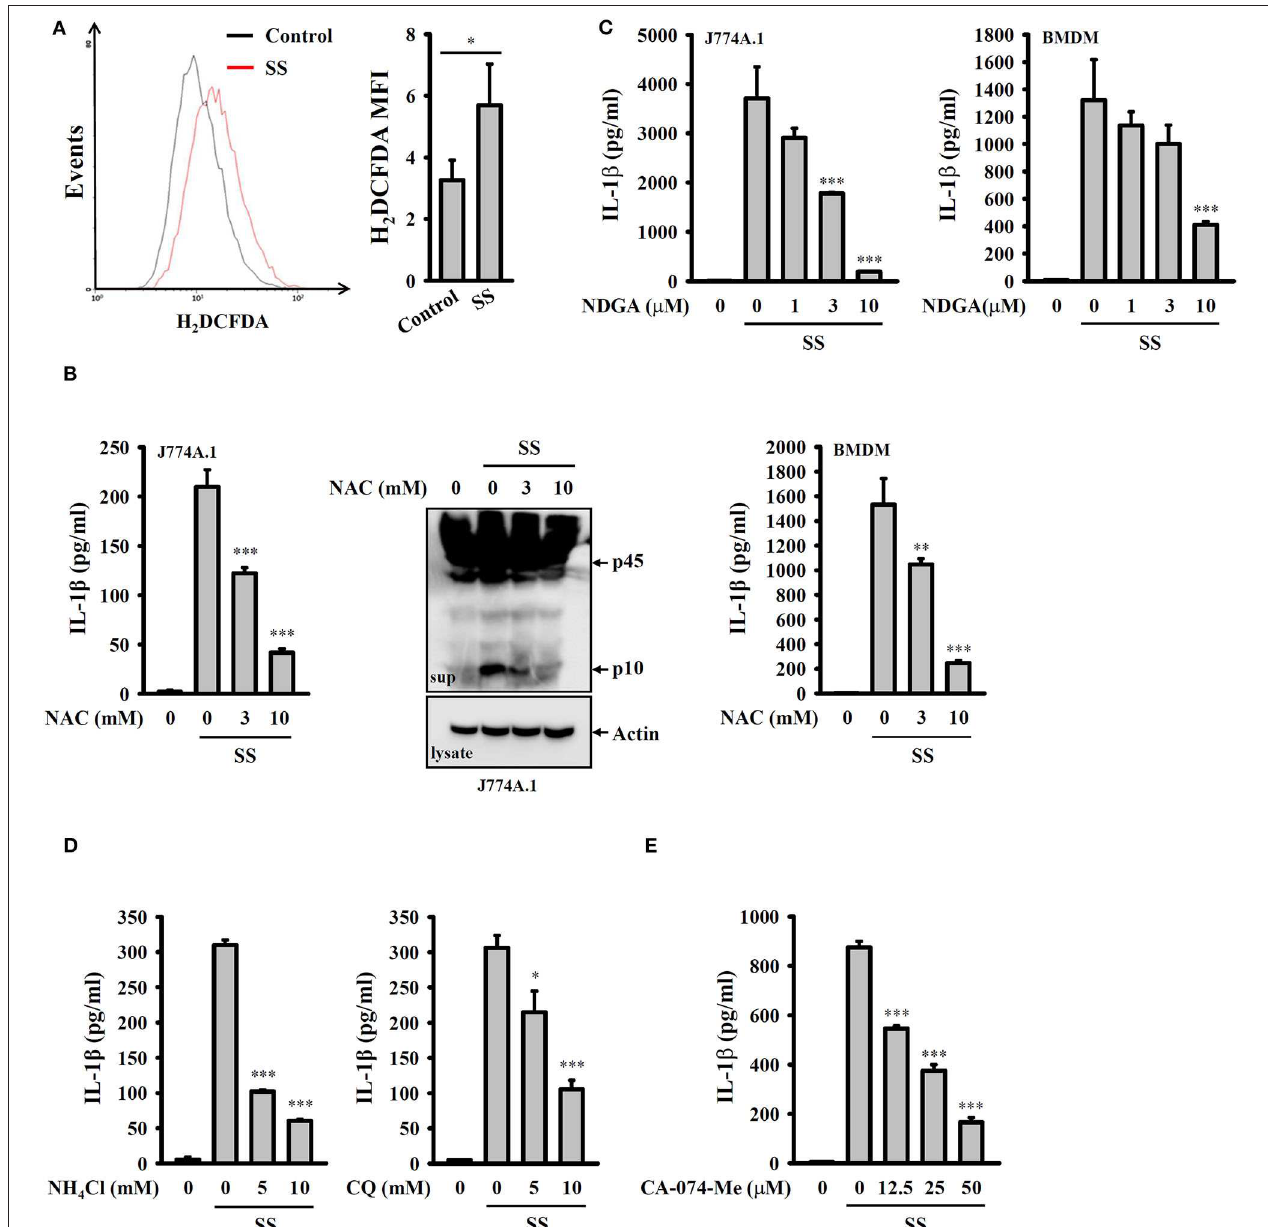
FIGURE 4 | S. sonnei activates the NLRP3 inflammasome through H 2 O 2 production and lysosomal damage. (A) J774A.1 macrophages were primed with 1 µ g/ml LPS for 4h and then infected with 50 MOI S. sonnei for an additional 20h. The levels of intracellular ROS were measured by CM-H 2 DCFDA staining, and the data were acquired by flow cytometry. (B) J774A.1 macrophages or BMDM were primed with 1 µ g/ml LPS for 4h and then treated with NAC for 0.5h. The cells were then infected with 50 MOI S. sonnei for an additional 20h. The levels of IL-1 β and caspase-1 in the supernatants were measured by ELISA and Western blotting, respectively. (C) J774A.1 macrophages or BMDM were primed with 1 µ g/ml LPS for 4h and then treated with NDGA for 0.5h. The cells were then infected with 50 MOI S. sonnei for an additional 20h. The levels of IL-1 β in the supernatants were measured by ELISA. (D,E) J774A.1 macrophages were primed with 1 µ g/ml LPS for 4h and then treated with NH 4 Cl and CQ (D) or CA-074-Me (E) for 0.5h. The cells were then infected with 50 MOI S. sonnei for an additional 20h. The levels of IL-1 β in the supernatants were measured by ELISA. The ELISA data are expressed as the mean ± SD of four separate experiments. The flow cytometry and Western blotting results are representative of three different experiments. *, **, and *** indicate significant differences at the levels of p < 0.05, p < 0.01 and p < 0.001, respectively, compared to untreated control cells (A) or S. sonnei -infected cells (B–E) [two-tailed t -test in panel (A) ; one-way ANOVA with Dunnett’s multiple comparisons test in panels (B–E)